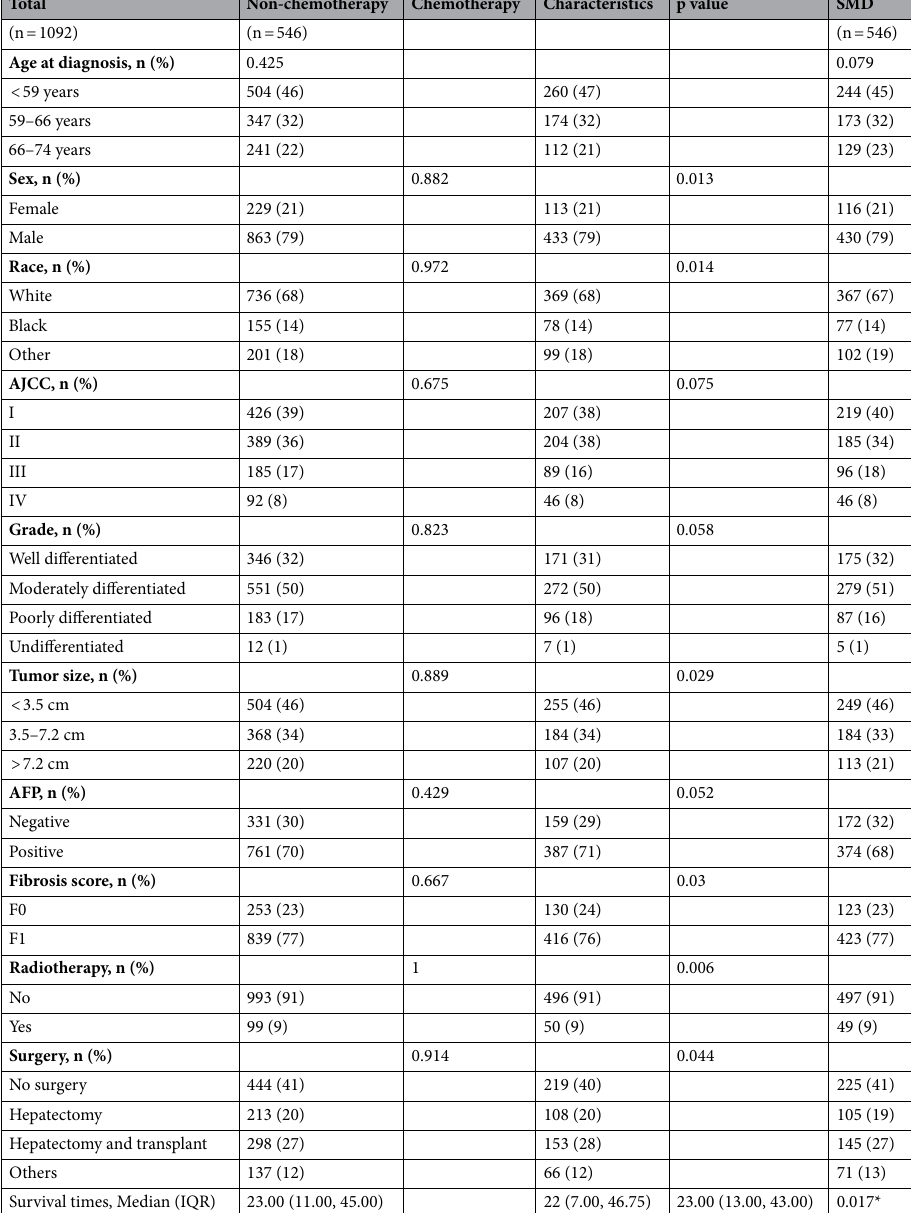
Table 1. Patients’ demographics and clinicopathological characteristics. *Two-sided P values < 0.05. **Two- sided P values < 0.01. ***Two-sided P values < 0.001. AJCC, American Joint Committee on Cancer (7th).